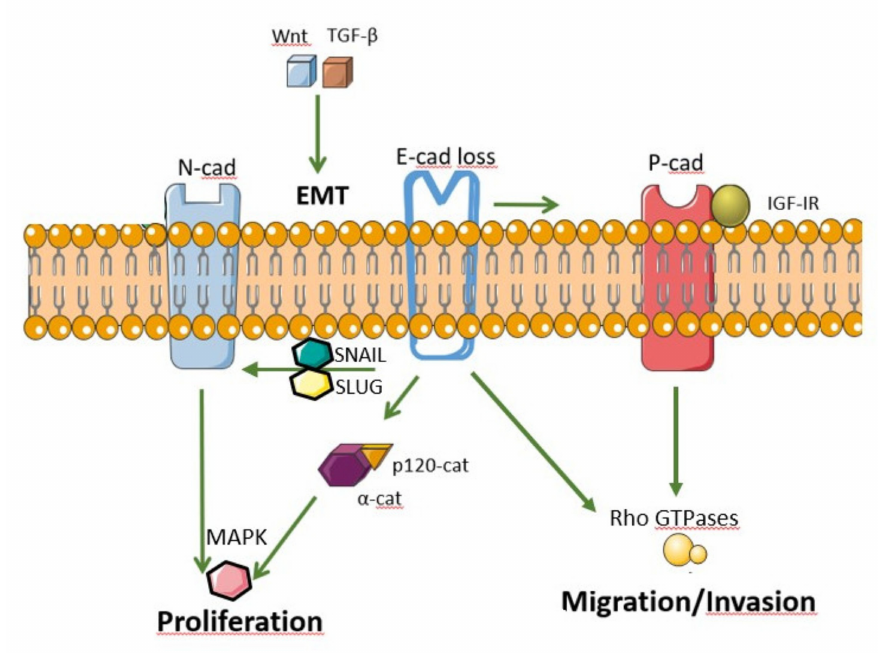
Figure 2. Common signaling pathways of epithelial-to-mesenchymal transition based on Albrecht et al. [80]. Snail and Slug regulate “cadherin switch” by downregulating E-cadherin (E-cad) and inducing the expression of mesenchymal neuronal-cadherin (N-cad). Signaling pathways such as Wnt and TGF- β activate SNAIL and SLUG. N-cad stimulates cell proliferation through mitogen activated protein kinase (MAPK) pathways. The loss of E-cad can also result in the mislocalization of α -catenin and p120 catenin, which leads to the activation of MAPK pathways. Somatic mutations of E-cad leading to its downregulation disrupt normal signaling to Rho GTPases (Rac1 and RhoA), which leads to tumor cell migration and invasion. Upregulated placental-cadherin (P-cad) induces the insulin-like growth factor 1 receptor (IGF-1R) signaling pathway, which also leads to Rho GTPase signaling that promotes migration and